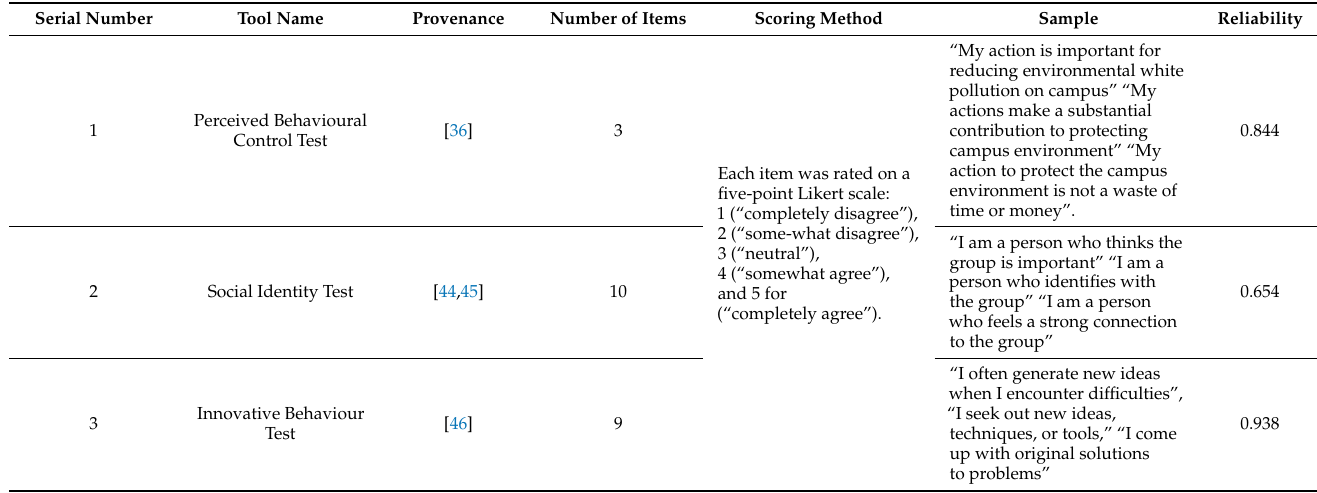
Table 1. Research